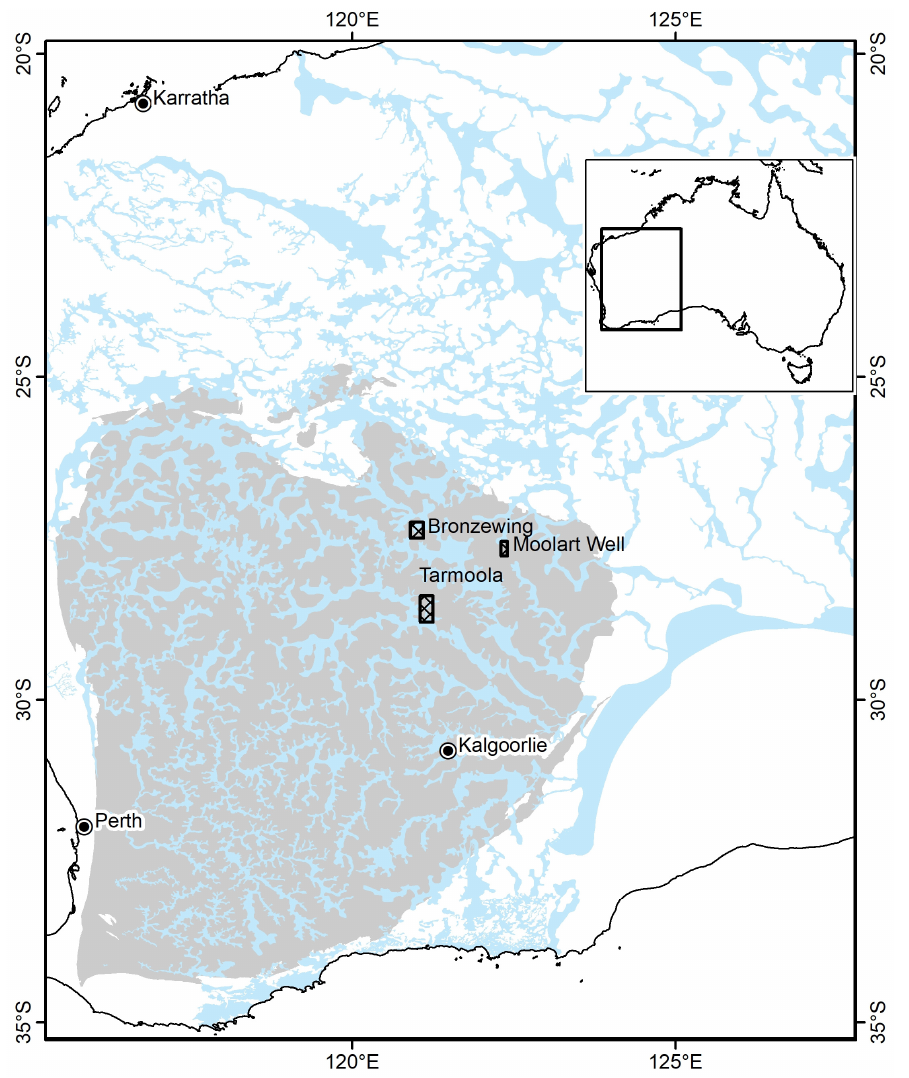
Figure 2. Location of three case study areas (black rectangles crosshatched) within the Yilgarn Craton in grey colour. The regional extent of the known mapped paleovalleys in blue after Bell, et al. [33].